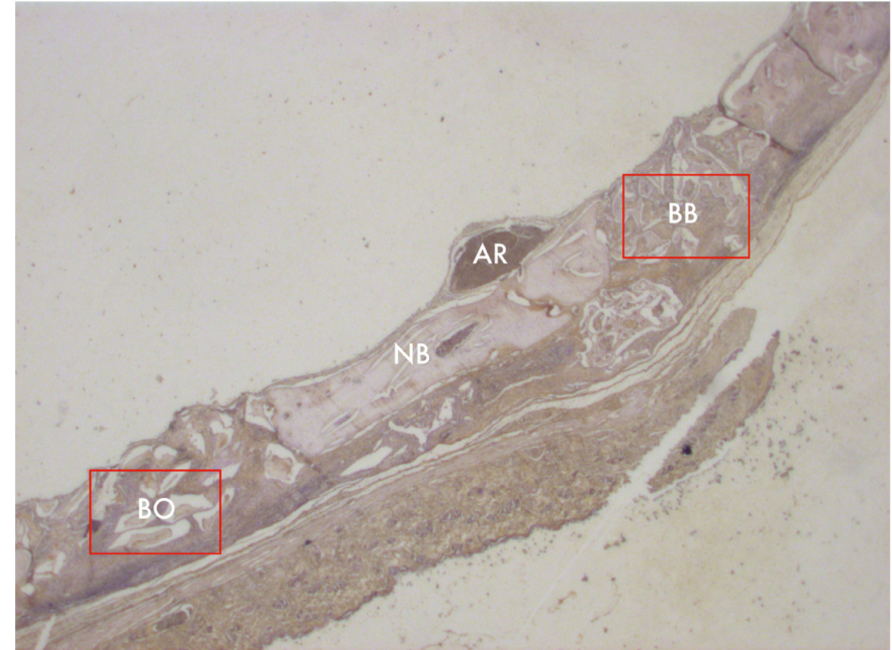
Figure 2. Photomicrograph of an animal calvaria sample 8 weeks after surgery; 1–25 × magnification. BO = Bio Oss; BB = Blue Bone; NB = native bone; AR =